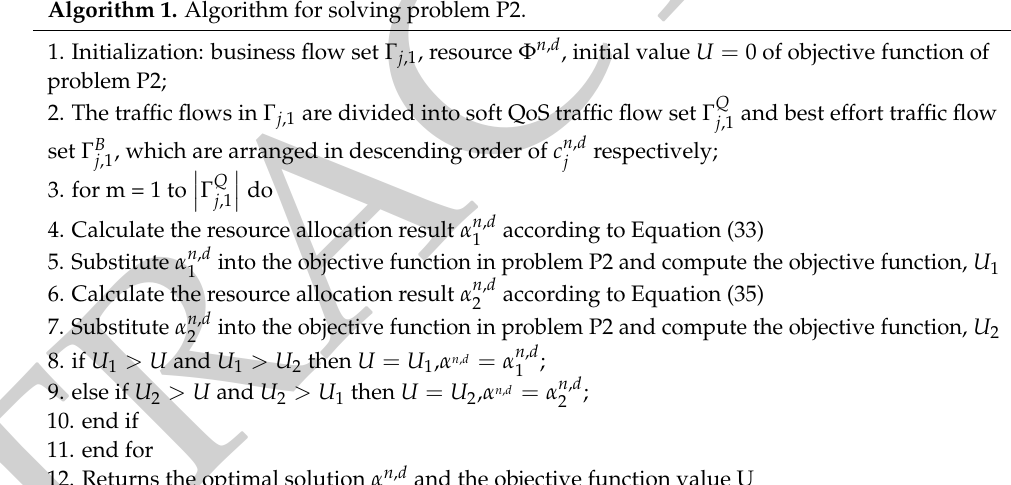
Algorithm 1. Algorithm for solving problem